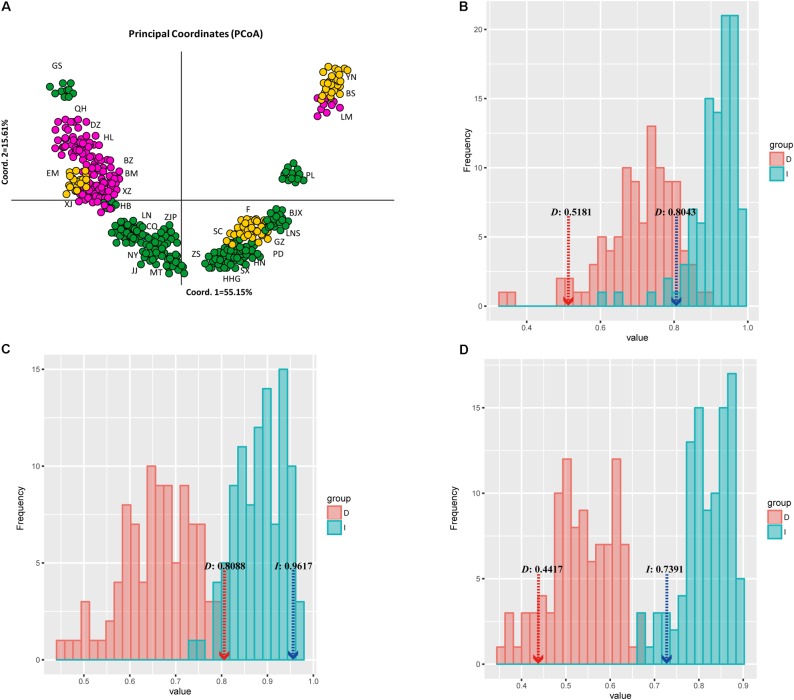
Plot of sampled sites or occurrence data for each of common walnut J. regia onto two principal components that summarize 70.76% of variance in 19 bioclimatic layers. Each taxon is represented by a different color, as indicated in the box at lower right of (A); (B) Niche identity tests for population A of J. regia/population B of J. regia, (C) Niche identity test for population A of J. regia/population C of J. regia, and (D) Niche identity test of population B of J. regia/population C of J. regia. Light red indicates Schoener’s D and its null distributions of 1,000 pseudo replicates; light blue indicates Warren’s et al. (2010). I and its null distributions of 1,000 pseudoreplicates. The dashed lines denote the observed values of Schoener’s D and Hellinger’s I with significant P-values for both niche overlap measures (P < 0.001).